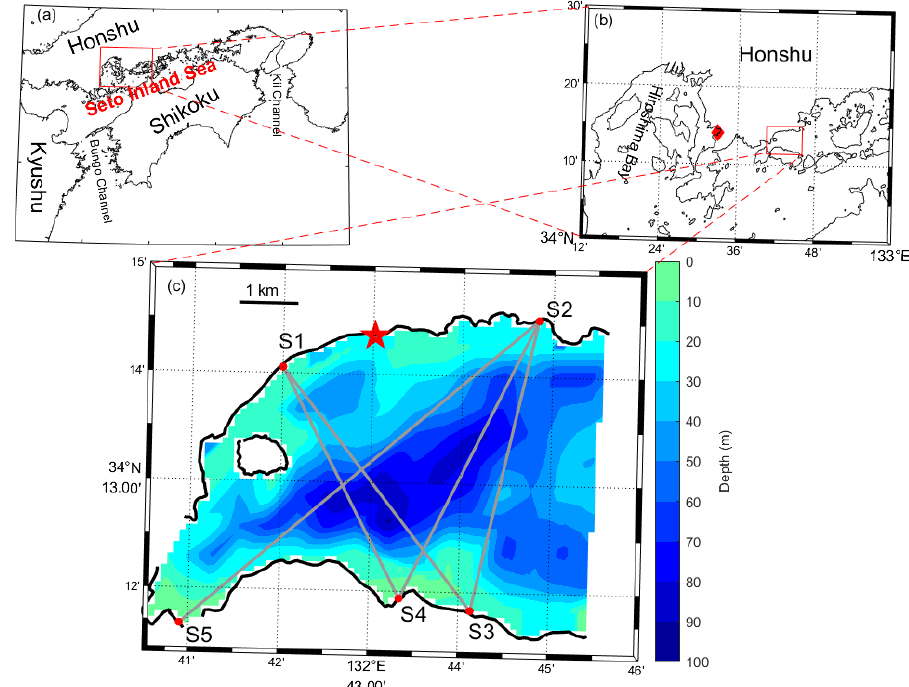
Figure 1. Location map of ( a ) Seto Inland Sea and ( b ) Neko-Seto Channel encircled with red rectangles. ( c ) The model domain with the bathymetric chart, accompanied by the color bar on the right side. The five acoustic stations (S1–S5) and the transmission paths connecting them are indicated with red dots and grey lines, respectively. The red star and diamond indicate the location of Koyo with the predicted sea-level data and the Kure tide gauge station, respectively. The 1 km scale is illustrated near the upper left corner.